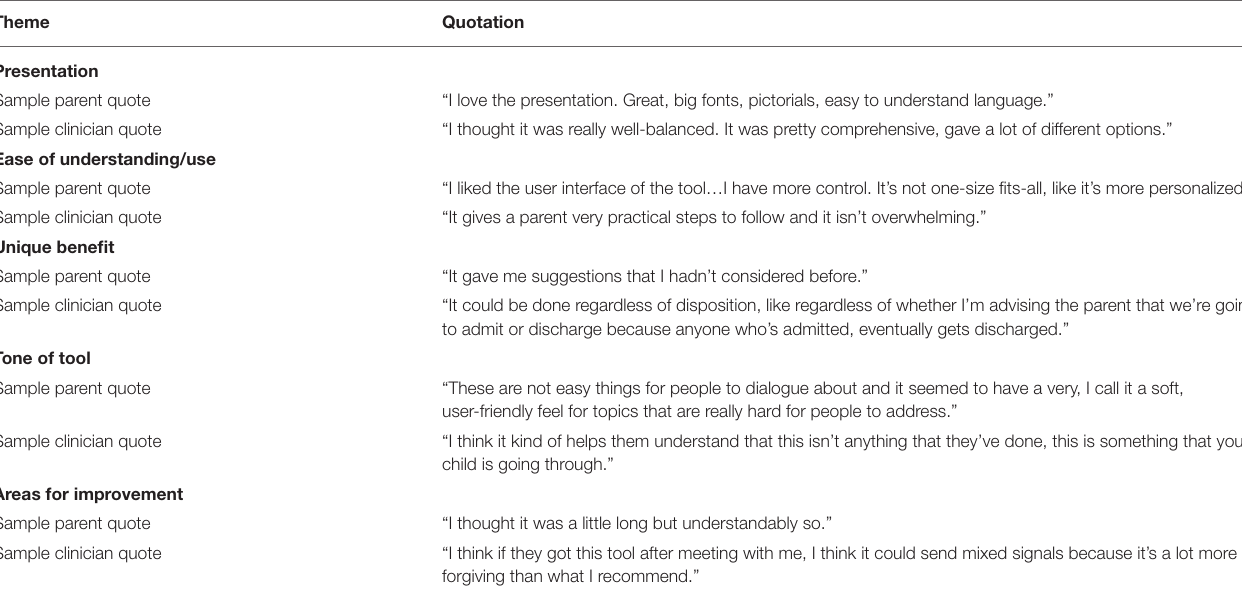
TABLE 4 | Qualitative feedback on “Lock and Protect” decision aid from parent and clinician